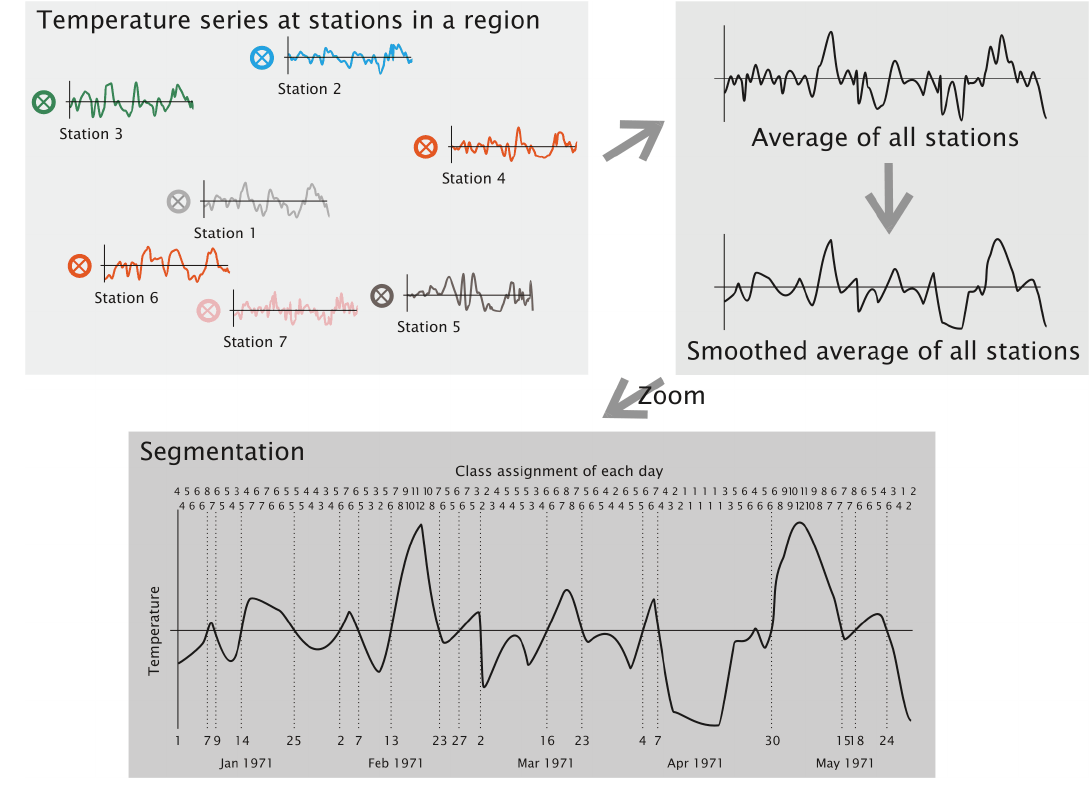
Figure 4. Schematic of the pre-processing steps that lead to the data base used by the WG to synthesize time series. Temperature time series from a target area are averaged, smoothed and segmented to form a pool of dates. The individual steps are described in the text.